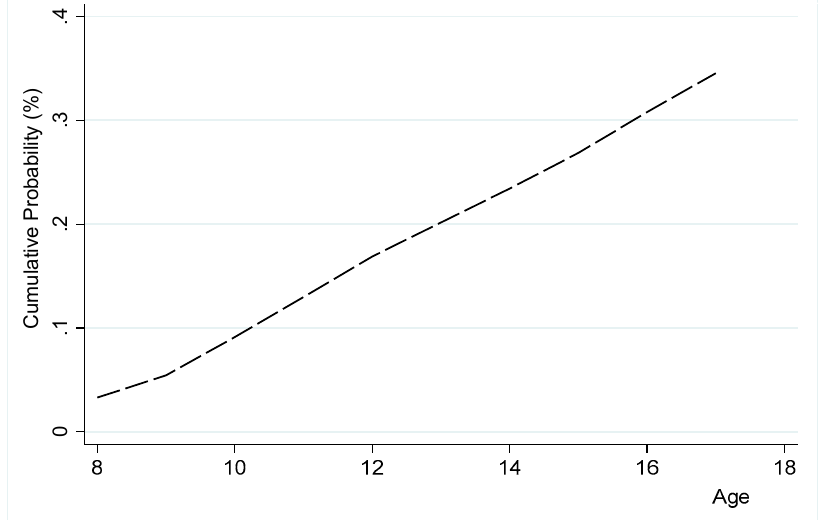
Figure 2. Cumulative risk of initiation into the use of tobacco products among youth (ages 8–17) in Nigeria.